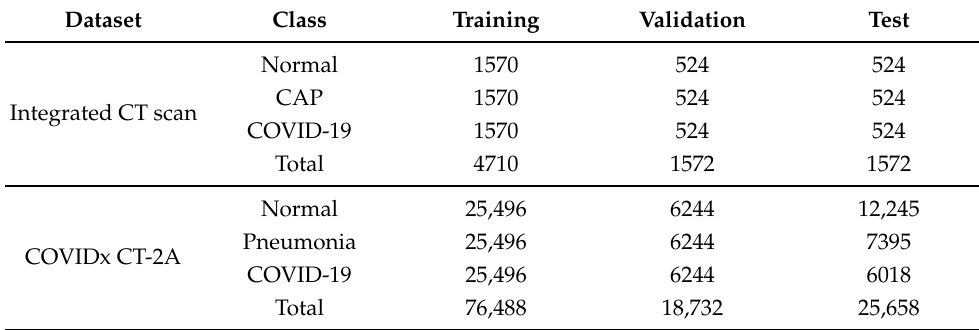
Table 1. Data distribution of training set, validation set, and test